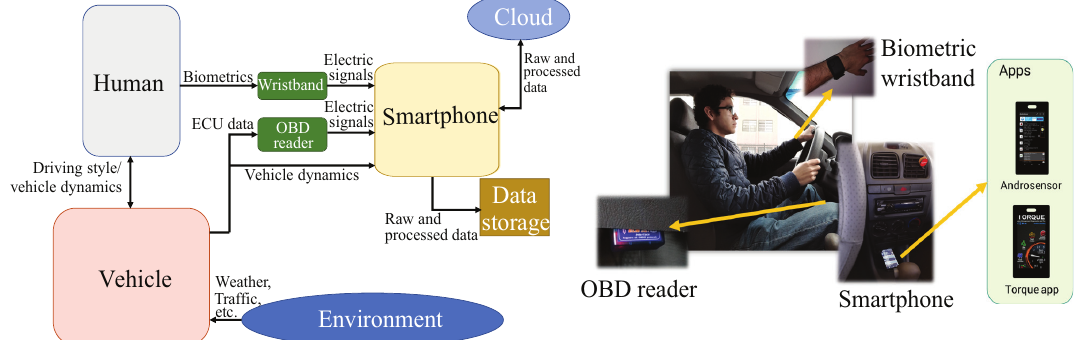
Figure 1. Experimental setup